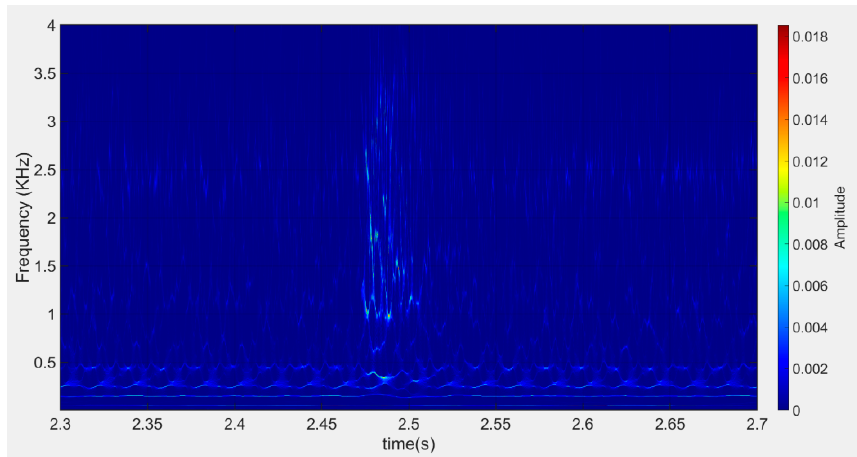
Figure 8. Typical spectrogram transformed by SWT.